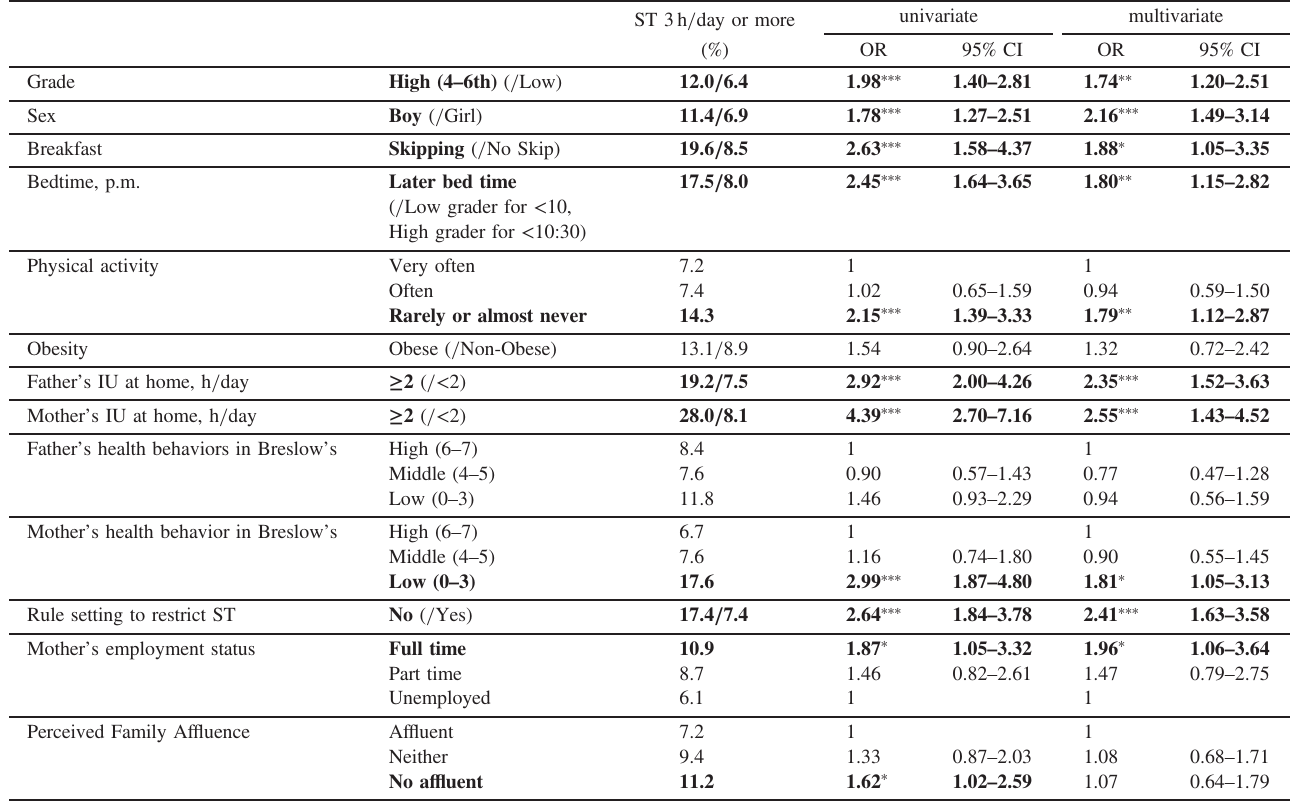
Table 2. Logistic regression analysis on children ’ s prolonged ST ( n = 1,659)